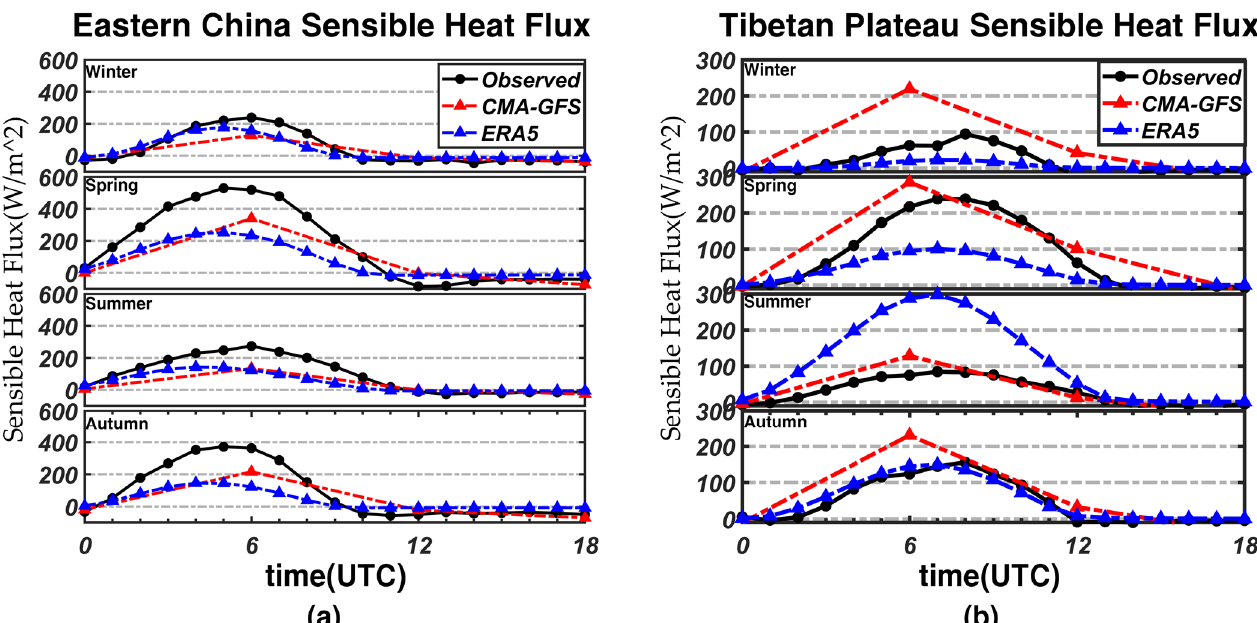
Figure 10. Station observations (black), CMA-GFS forecasts (red), and ERA5 dataset (blue) of the sensible heat flux in different seasons for ( a ) Eastern China and the ( b ) Qinghai–Tibetan Plateau.